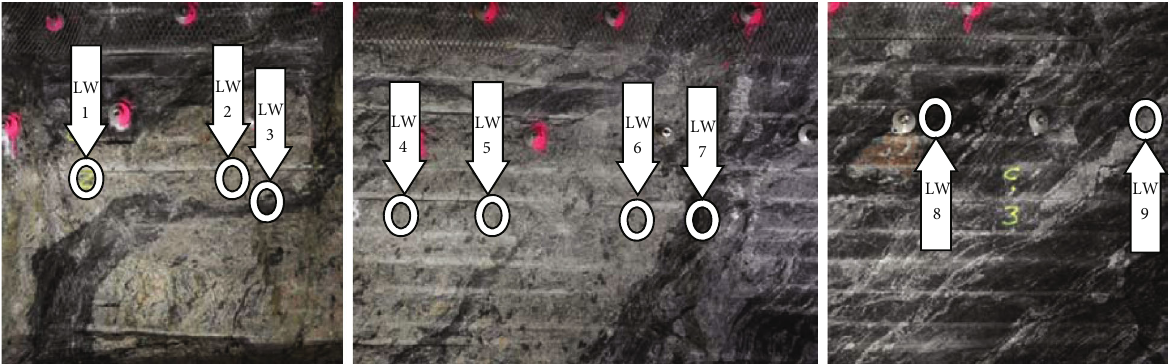
Figure 6: Demo 3 left wall.